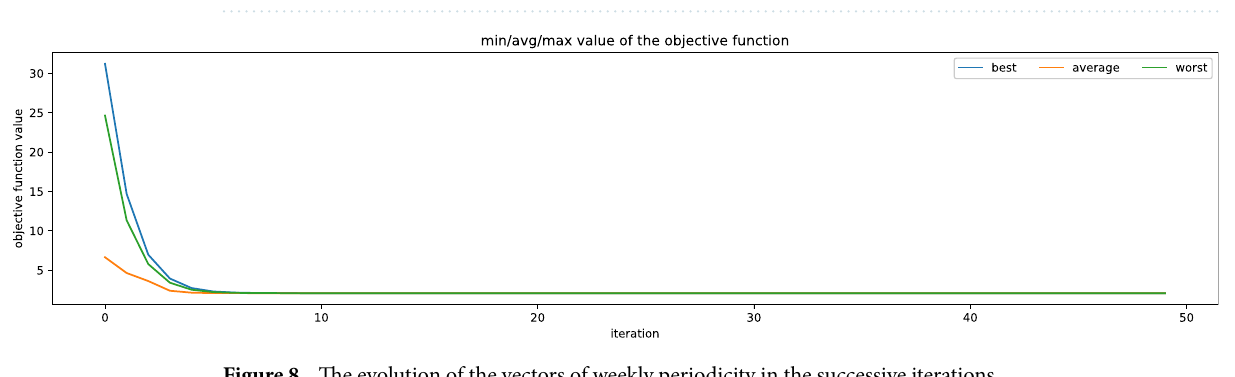
Figure 8. The evolution of the vectors of weekly periodicity in the successive